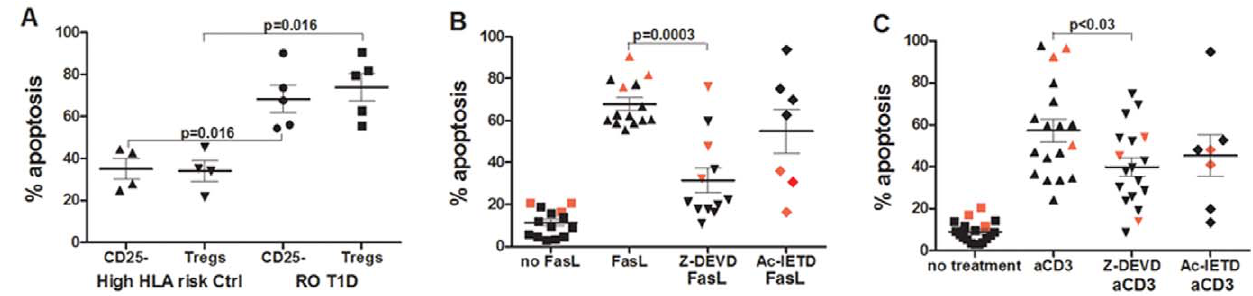
Figure 5. Fas/FasL T-cell apoptosis prevalent in RO T1D, LS T1D and Low HLA risk controls. A) In vitro soluble FasL caused significantly lower T cell apoptosis (in both naı¨ve-CD25 and Tregs) in healthy High HLA risk control subjects compared to RO T1D T cells (for both cell subset comparisons Mann-U-Whitney test was p=0.016), suggesting that Fas/FasL is one of the prevalent apoptosis mechanism in RO T1D subjects, but not in High HLA risk control subjects. B) Treg apoptosis caused by soluble FasL (1/40 dilution – 600 ng/ml) in healthy control, RO T1D and LS T1D subjects was significantly reduced with pretreatment with caspase 3 inhibitor Z-DEVD in majority of subjects. However, analysis of RO T1D subjects alone (red symbols) showed their better responsiveness to pretreatment with Ac-IETD compared to Z-DEVD. C) Activation-induced Treg apoptosis by anti-CD3 was moderately prevented through treatment of both inhibitors, suggesting an involvement of both caspase 3 and 8 in this apoptosis pathway in all subject groups. RO T1D subjects were labeled with red symbols. Mann-U-Whitney test was used for comparisons.